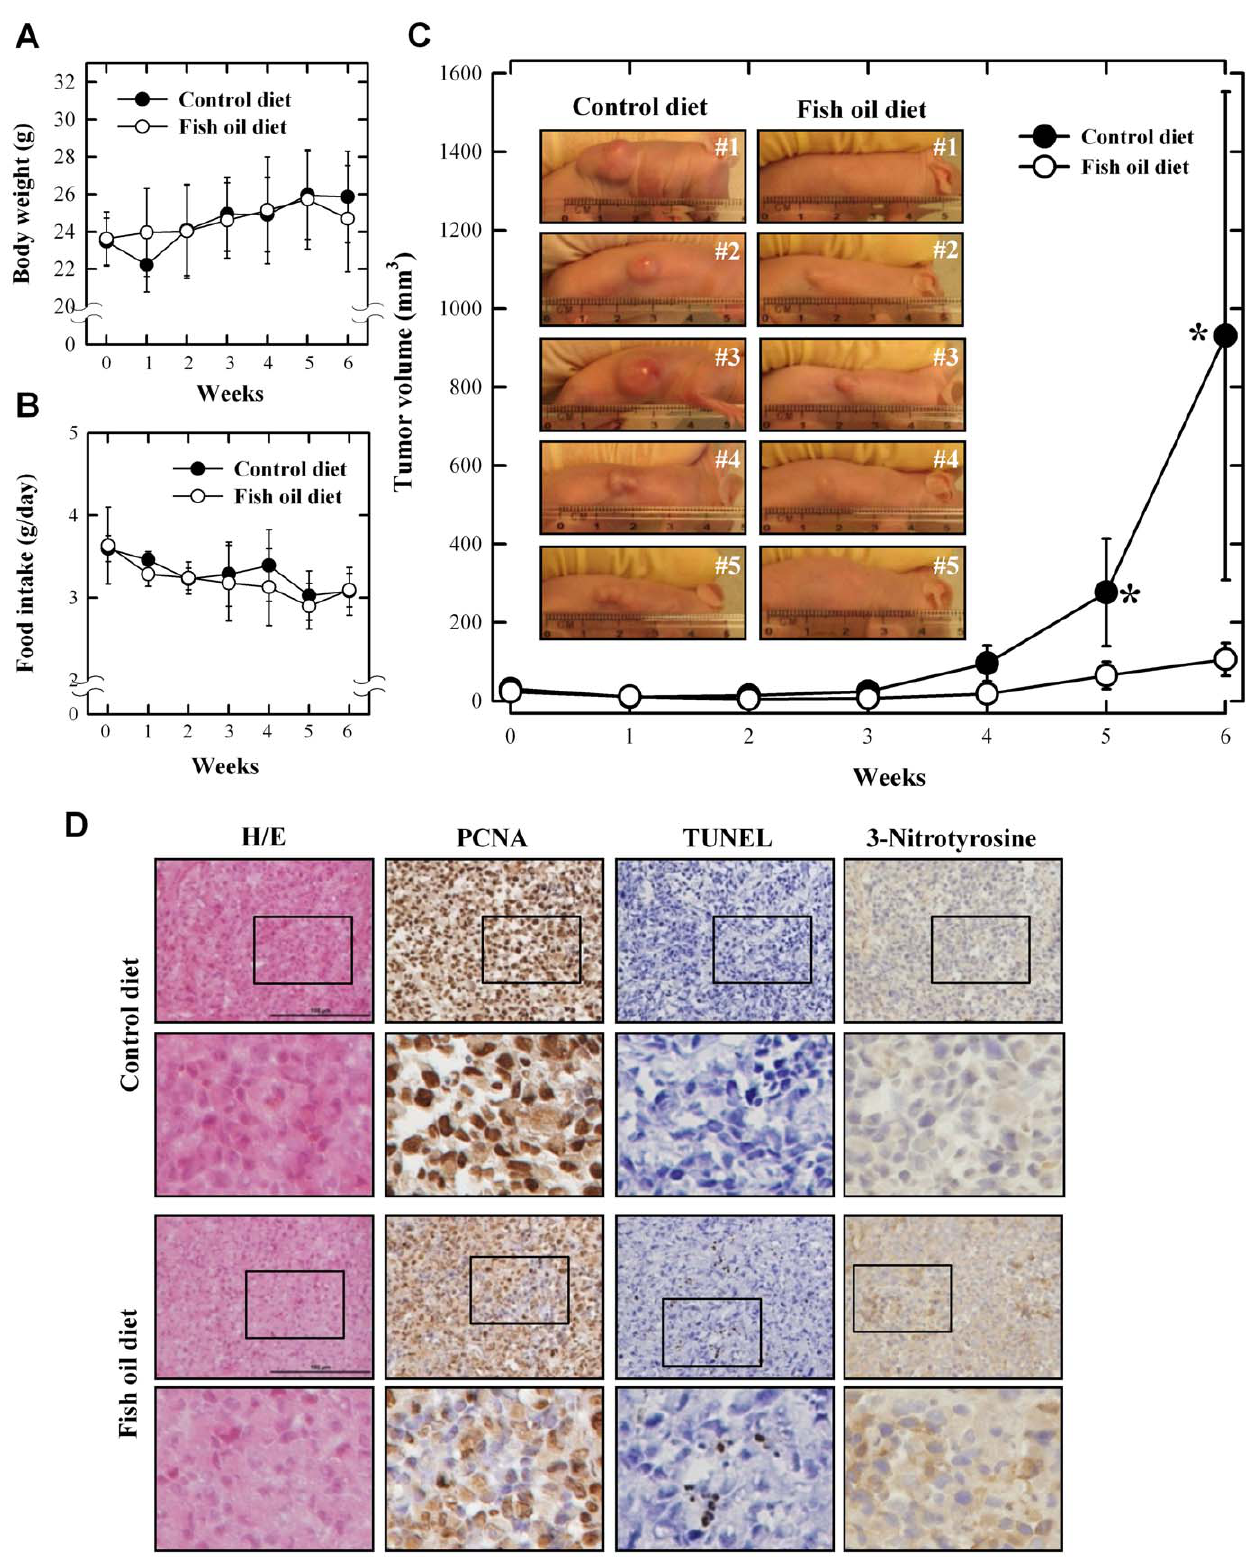
Figure 4. Fish oil-supplemented diet inhibits the growth of MCF-7 cancer cell xenografts in athymic nude mice. The changes in body weight ( A ), food intake amount ( B ) and tumor growth ( C ). The macroscopic pictures of tumor ( C ) and morphological and histopathological analyses ( D ) were assessed at the end of experiments. Nude mice were maintained on control or fish oil diet for 10 weeks after subcutaneous implantation of MCF-7 cells (5 6 10 6 cells in 100 m L PBS). Both maximum and minimum diameters of the tumors, body weight and food intake amounts were measured twice a week using slide caliper. Tumor volume was calculated assuming the tumor to be spherical using the formula [ p /6 6 d 3 ], where d is the mean diameter.